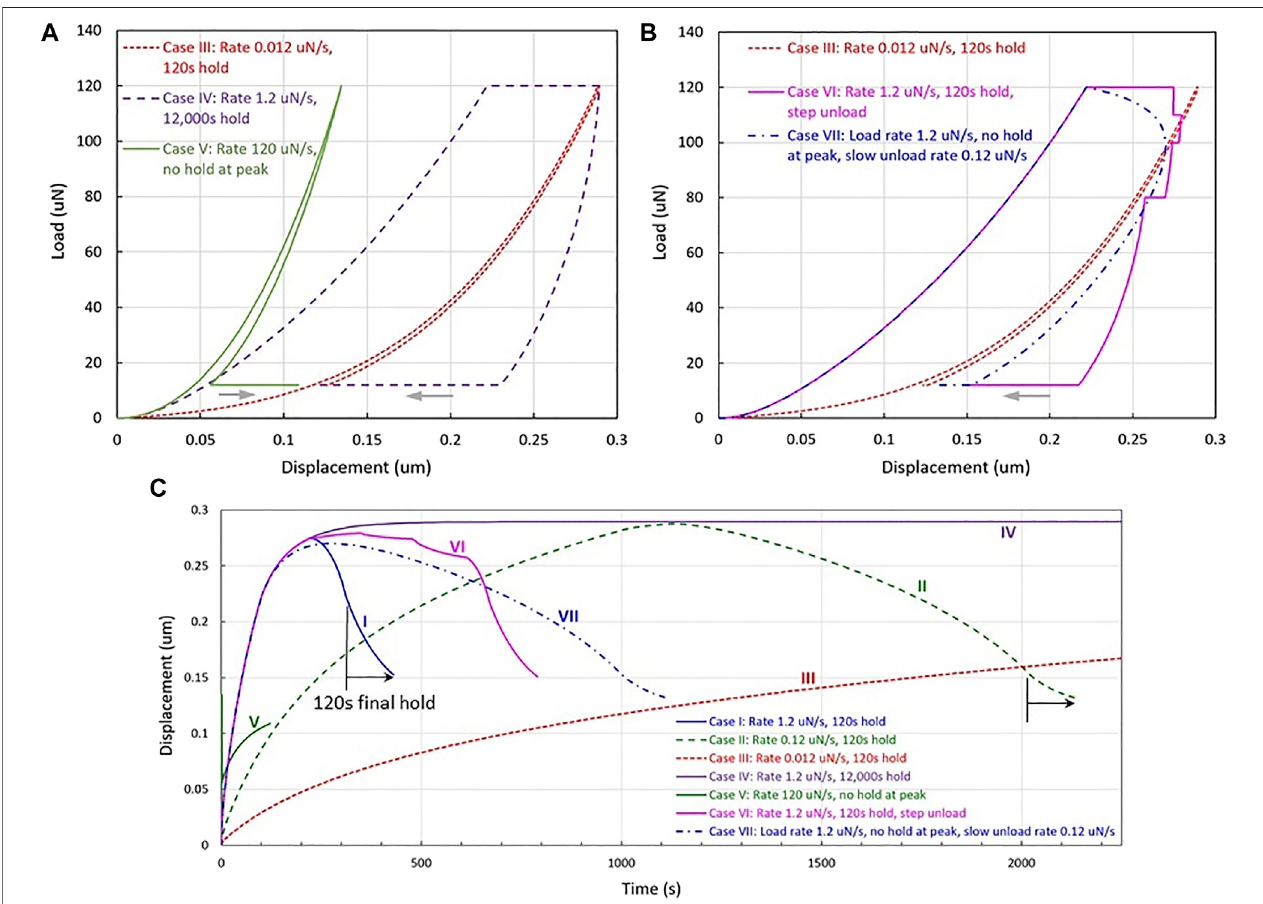
FIGURE2| Simulatedindentationload-displacementcurvesfor (A) CasesIII,IVandV,and (B) CasesIII,VIandVII.CaseIIIareincludedinbothplotsasareference response(fullyrelaxed) (C) Simulatedindentationdisplacement-timehistoriesforallcasesIthroughVII.Thelast120 sofconstant-loadholdperiodsforCasesIandIIare highlighted for